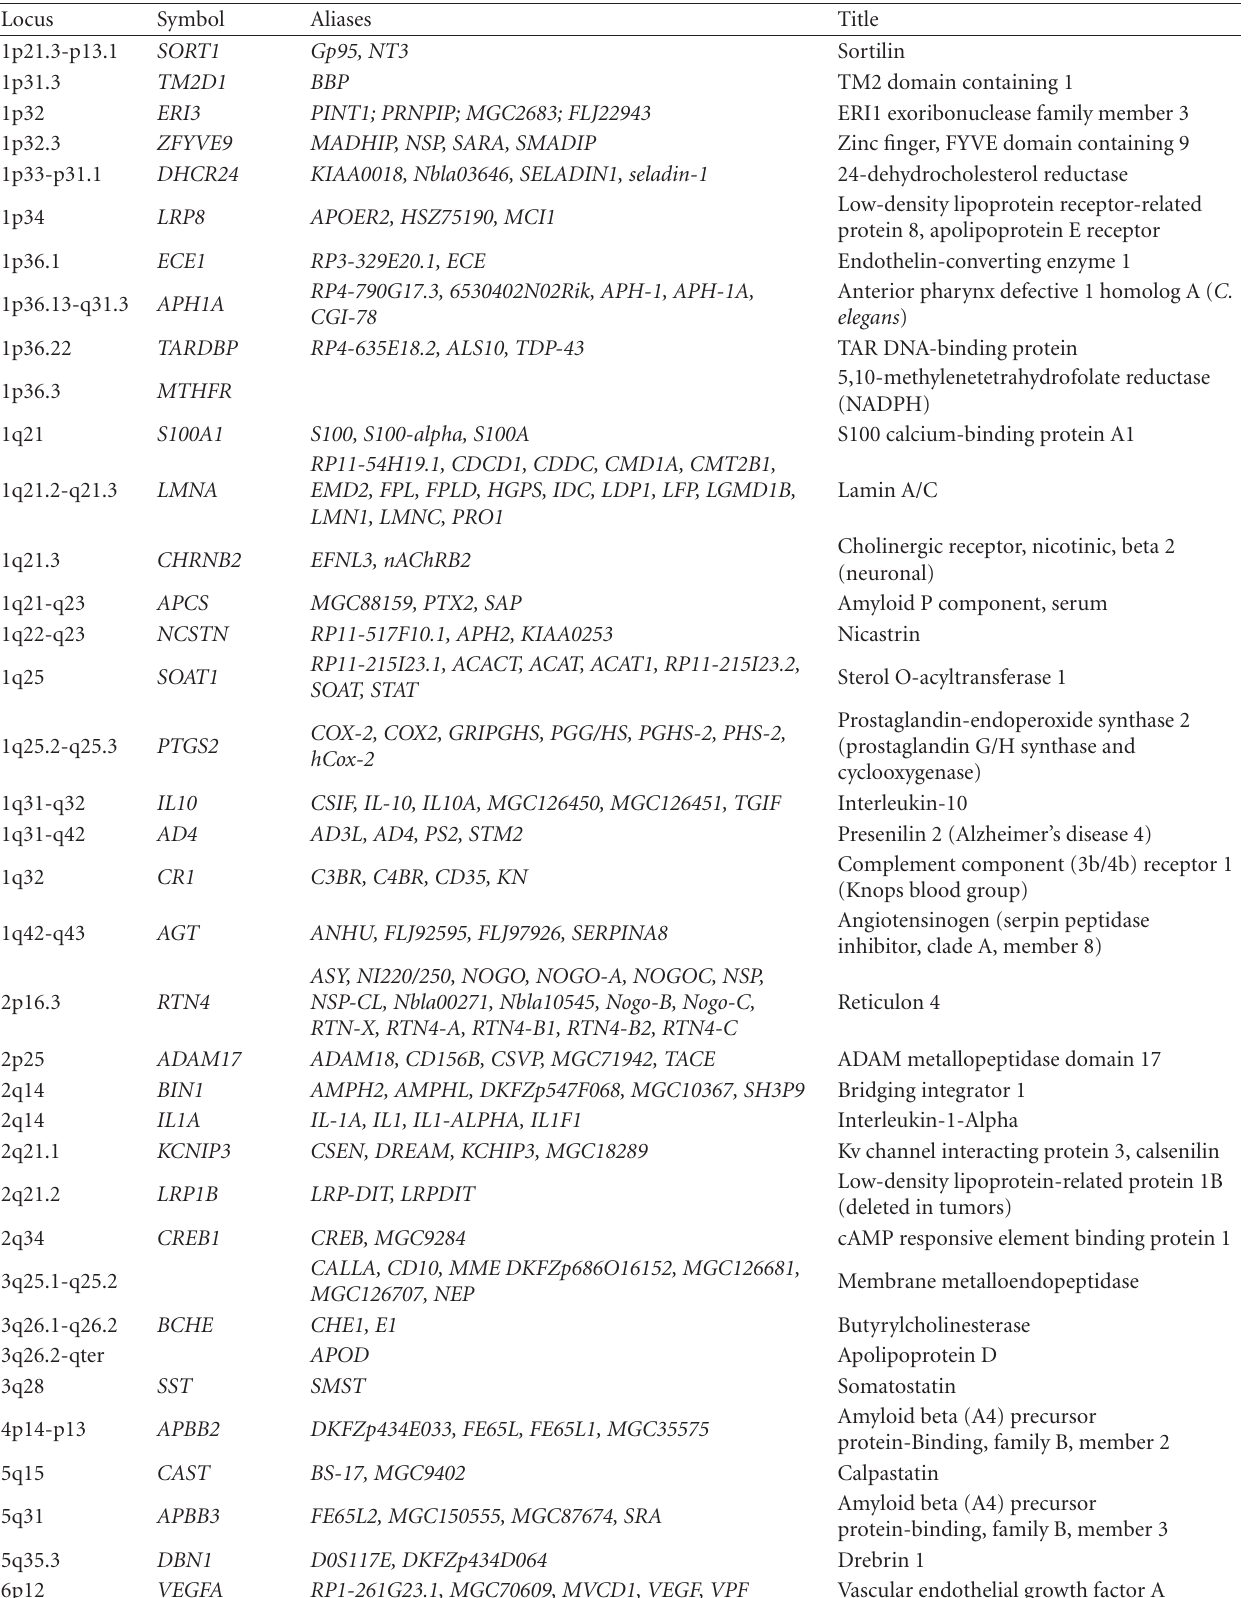
Table 1: Selected human genes investigated as potential candidate genes associated with dementia and age-related neurodegenerative disorders